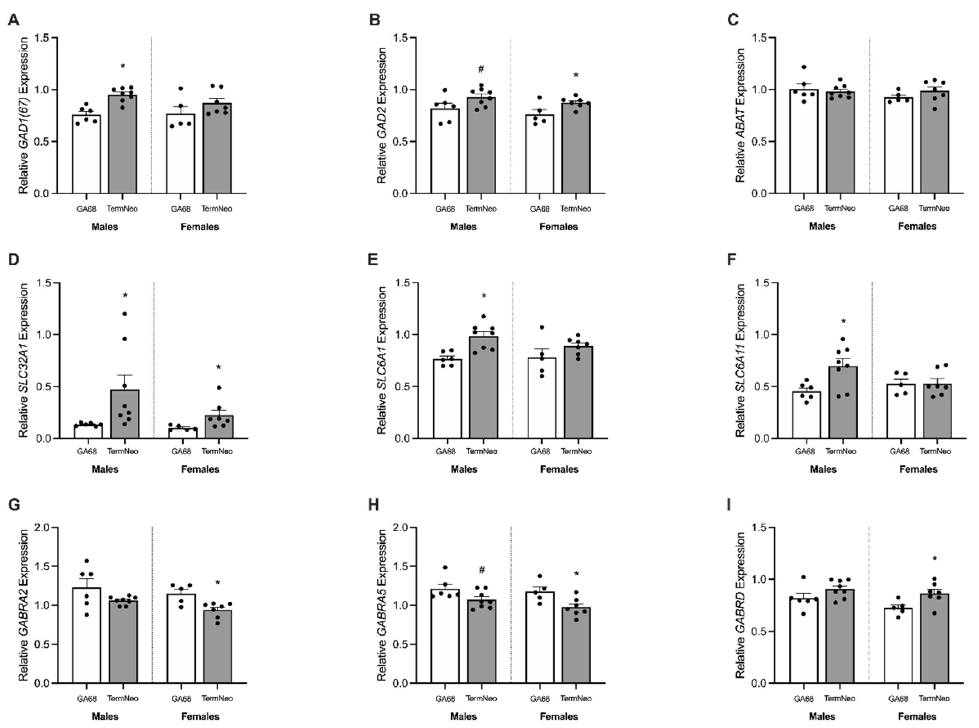
Figure 4. Relative mRNA expression for GABA synthesis, breakdown, transport, and receptor markers in the hippocampus of fetal GA68 (white; males n = 6, females n = 5) and term neonates (grey; males n = 8, females n = 7). ( A ) GAD1(67) , ( B ) GAD2 , ( C ) ABAT , ( D ) SLC32A1 , ( E ) SLC6A1 , ( F ) SLC6A11 , ( G ) GABRA2 , ( H ) GABRA5 , and ( I ) GABRD . Data presented as means ± SEM with * indicating significance at p < 0.05, and # representing a non-significant trend.